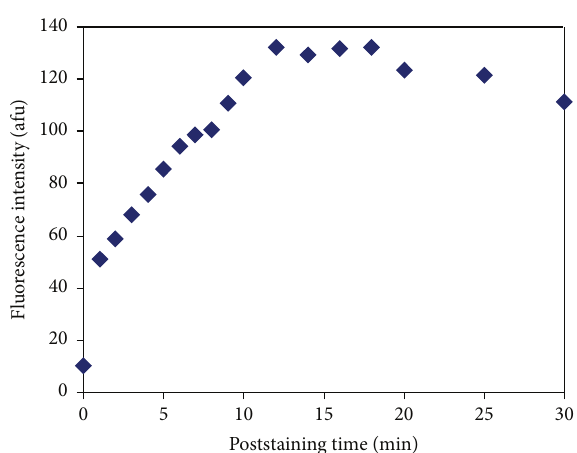
Figure 2: The effect of poststaining time on the fluorescence intensity of stained microalgal culture. Excitation wavelength = 530 nm and emission wavelength = 580 nm.